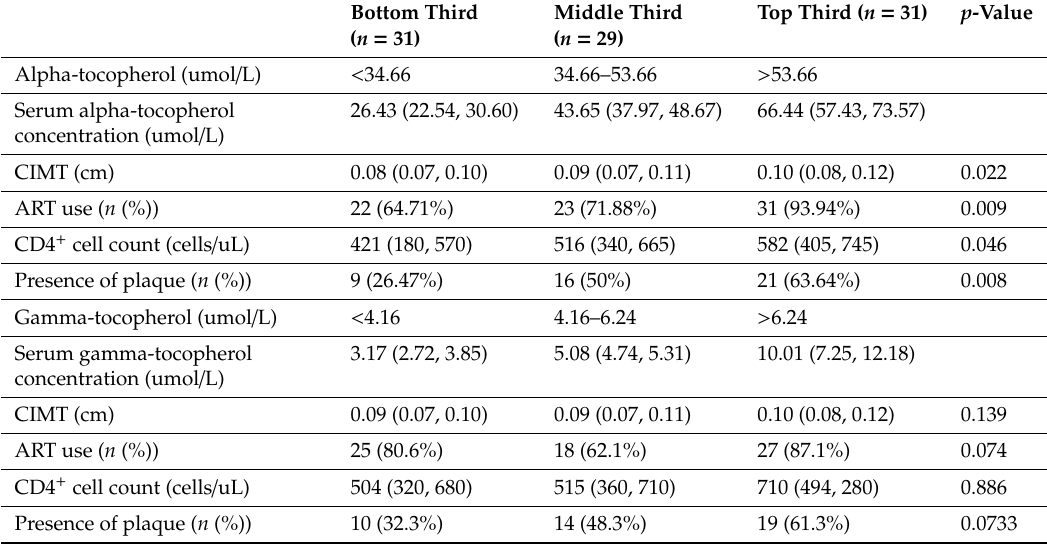
Table 3. Clinical characteristics by tertiles of alpha-tocopherol and gamma-tocopherol. Bottom Third Middle Third Top Third ( n = 31) p -Value ( n = 31) ( n = 29)